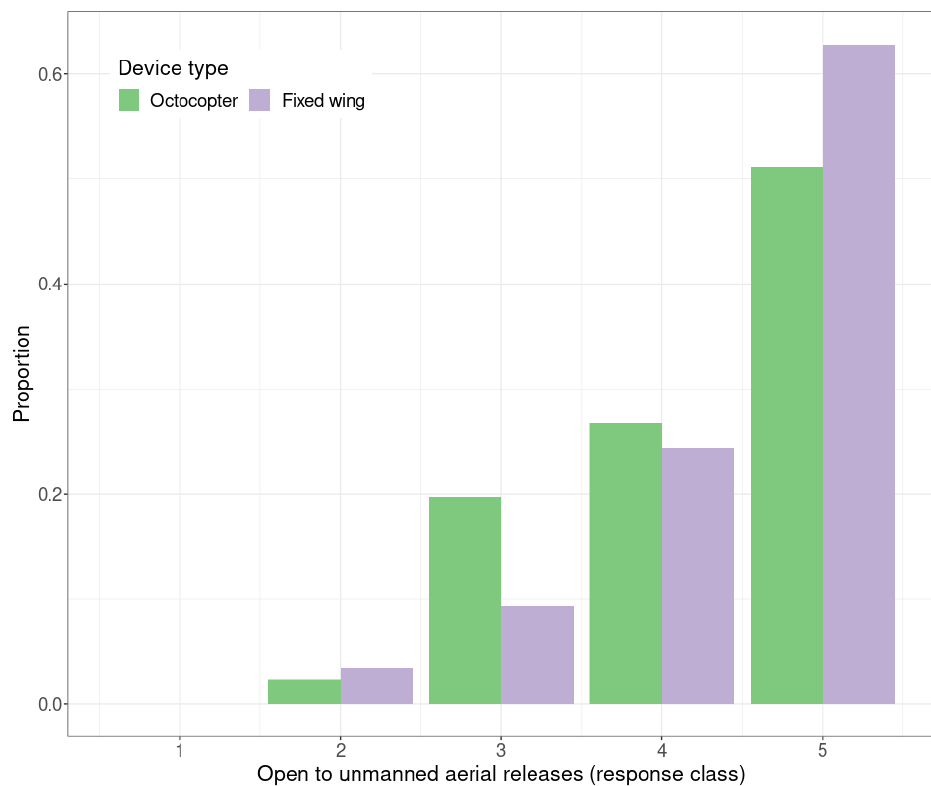
Figure 5. Response of the participants to the use of unmanned aerial vehicles that are of fixed-wing type, compared with the use of octocopters (helicopter type). The scale ranges from 1 to 5 (1 = not open at all, 5 = very open).